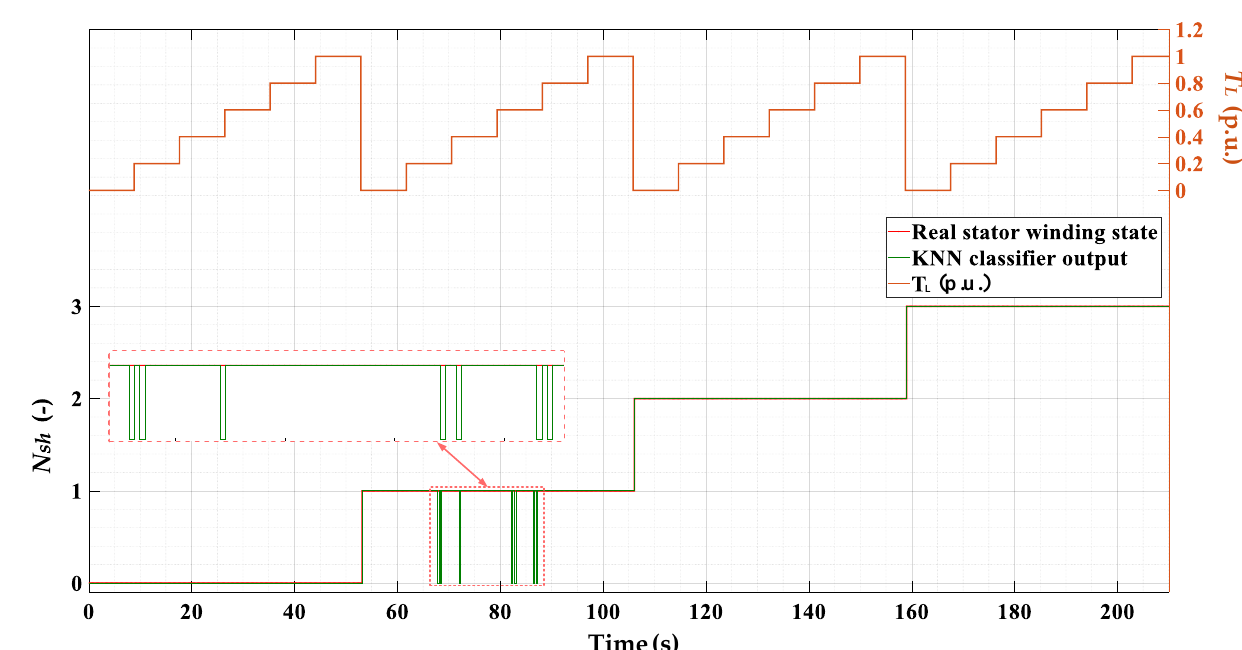
Figure 14. KNN-based stator winding fault classifier responses during the on-line operation—Test 1 ( f s = 100 Hz, T L = var).